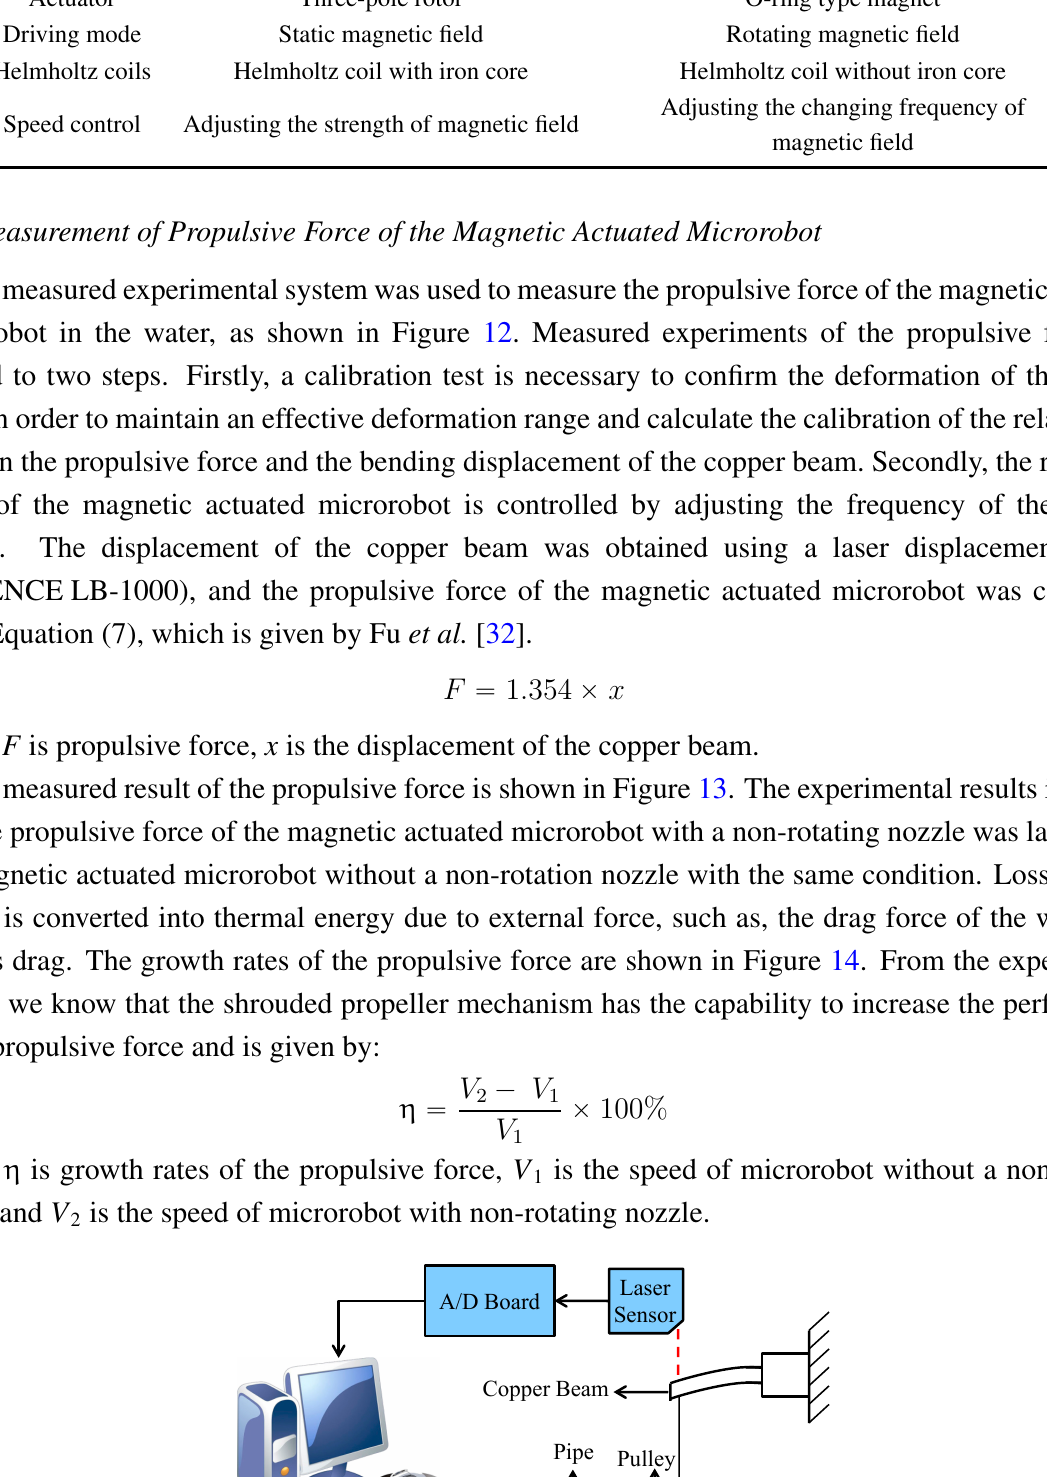
Table 2. Performance of magnetic actuated microrobot.